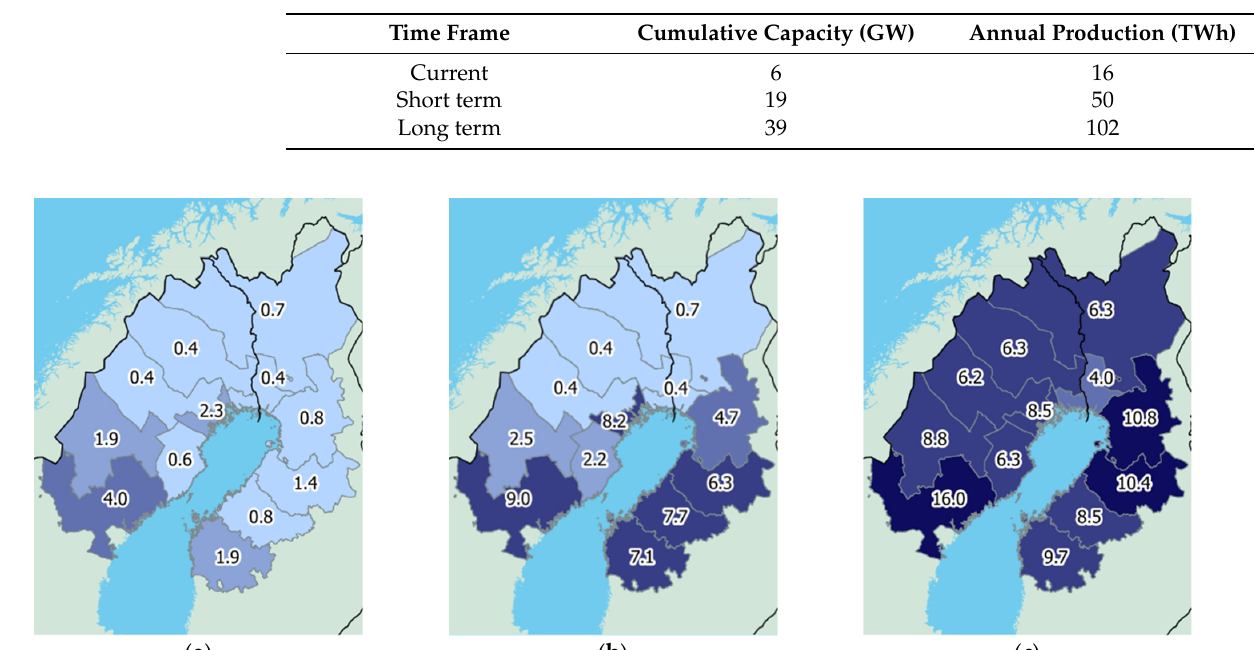
Figure 9. ( a ) Annual wind power production (TWh) from current turbines; ( b ) corresponding production when the short-term capacity additions are included; ( c ) production with long-term assumptions. Table 1. Estimated wind power capacities in the Bothnian Bay region.